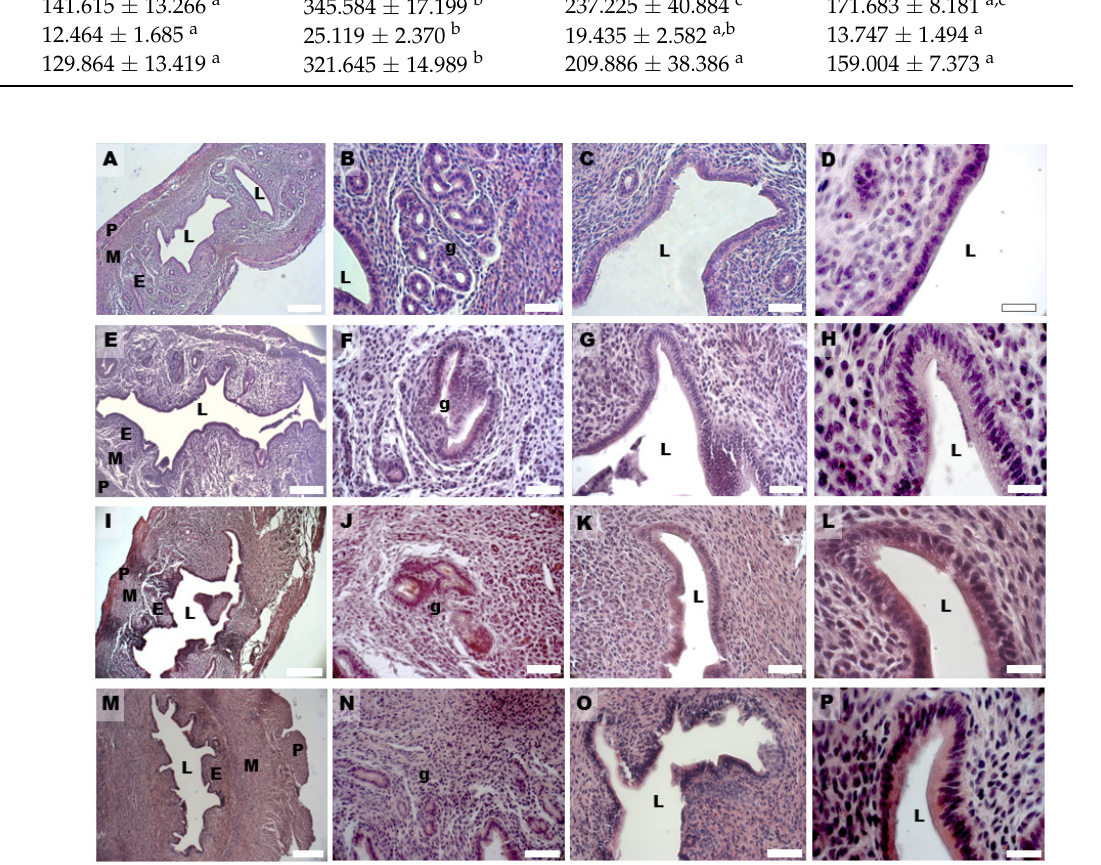
Figure 2. HE staining of mouse uterine horns of control ( A – D ), DHEA ( E – H ), DHEA/LC ‐ ALC ( I – L ) and DHEA/LC ‐ ALC ‐ PLC ( M – P ) groups. ( A , E , I , M ) low ‐ magnification LM pictures of the lumen (L), endometrium (E), myometrium (M) and perimetrium (P). ( B , F , J , N ) glandular epithelium. ( C , G , K , O ) luminal epithelium; ( D , H , L , P ) high magnification of the luminal epithelium made of columnar cells. LM, mag. 10x (( A , E , I , M ) Bar: 200 μ m), 20x (( B , C , F , G , J , K , N , O ) Bar: 50 μ m), 40x (( D , H , L , P ) Bar: 20 μ m). significative differences with respect to the control and DHEA groups (epithelium: 19.435 ± 2.582; p > 0.05); differently, the endometrium significantly decreased with respect to the DHEA group (237.225 ± 40.884 μ m vs. 345.584 ± 17.199 μ m, DHEA/LC ‐ ALC vs. DHEA; p < 0.01) but not with respect to the control (237.225 ± 40.884 μ m vs. 141.615 ± 13.266 μ m; p